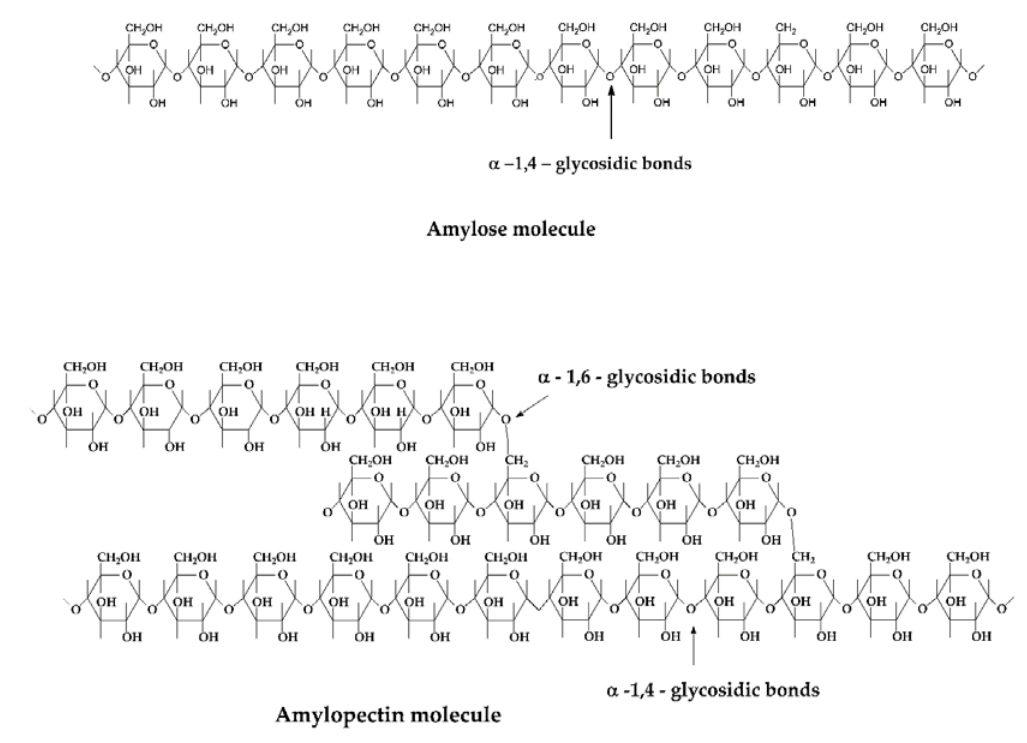
Figure 2. Starch structure emphasizing the two main components: amylose and amylopectin.